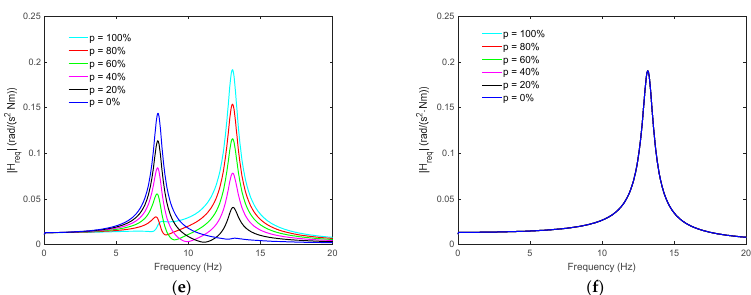
Figure 5. Examples of magnitude plots of H req ( j ω ) for the di ff erent EV layouts at 20 km / h: ( a ) L1: Single-speed 2WD; ( b ) L2: 2-speed 2WD; ( c ) L3: Single-speed 4WD; ( d ) L4: 2-speed 4WD (with states indicated according to Table 2); ( e ) L4: 2-speed 4WD (second gear on front axle, first gear on rear axle); ( f ) L4: 2-speed 4WD (second gear on front and rear axles).